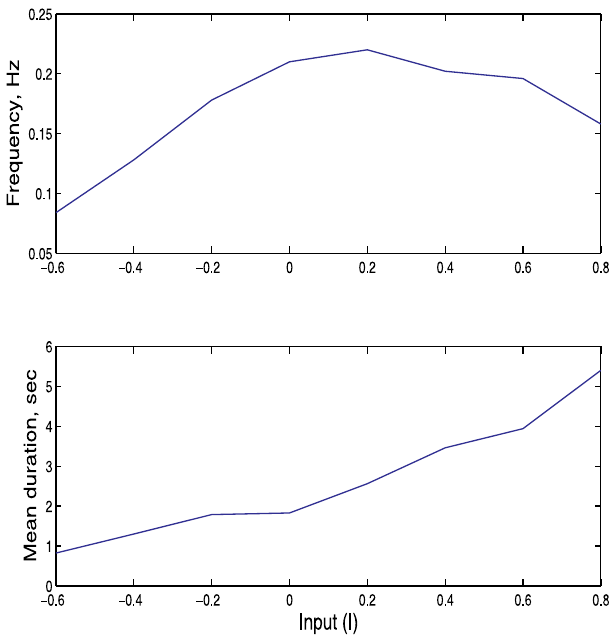
Figure 3. Frequency and Duration of the Mean Time Spent in the Up State as a Function of I The top graph represents the frequency of Up states as a function of Input I. Hyperpolarizing the neurons is generated for I , 0, while depolarization is generated for I . 0. The result suggests that there is a unique value of I for which the frequency of the Up state is maximal. In the bottom graph, the mean duration of the Up states is plotted as a function of I.